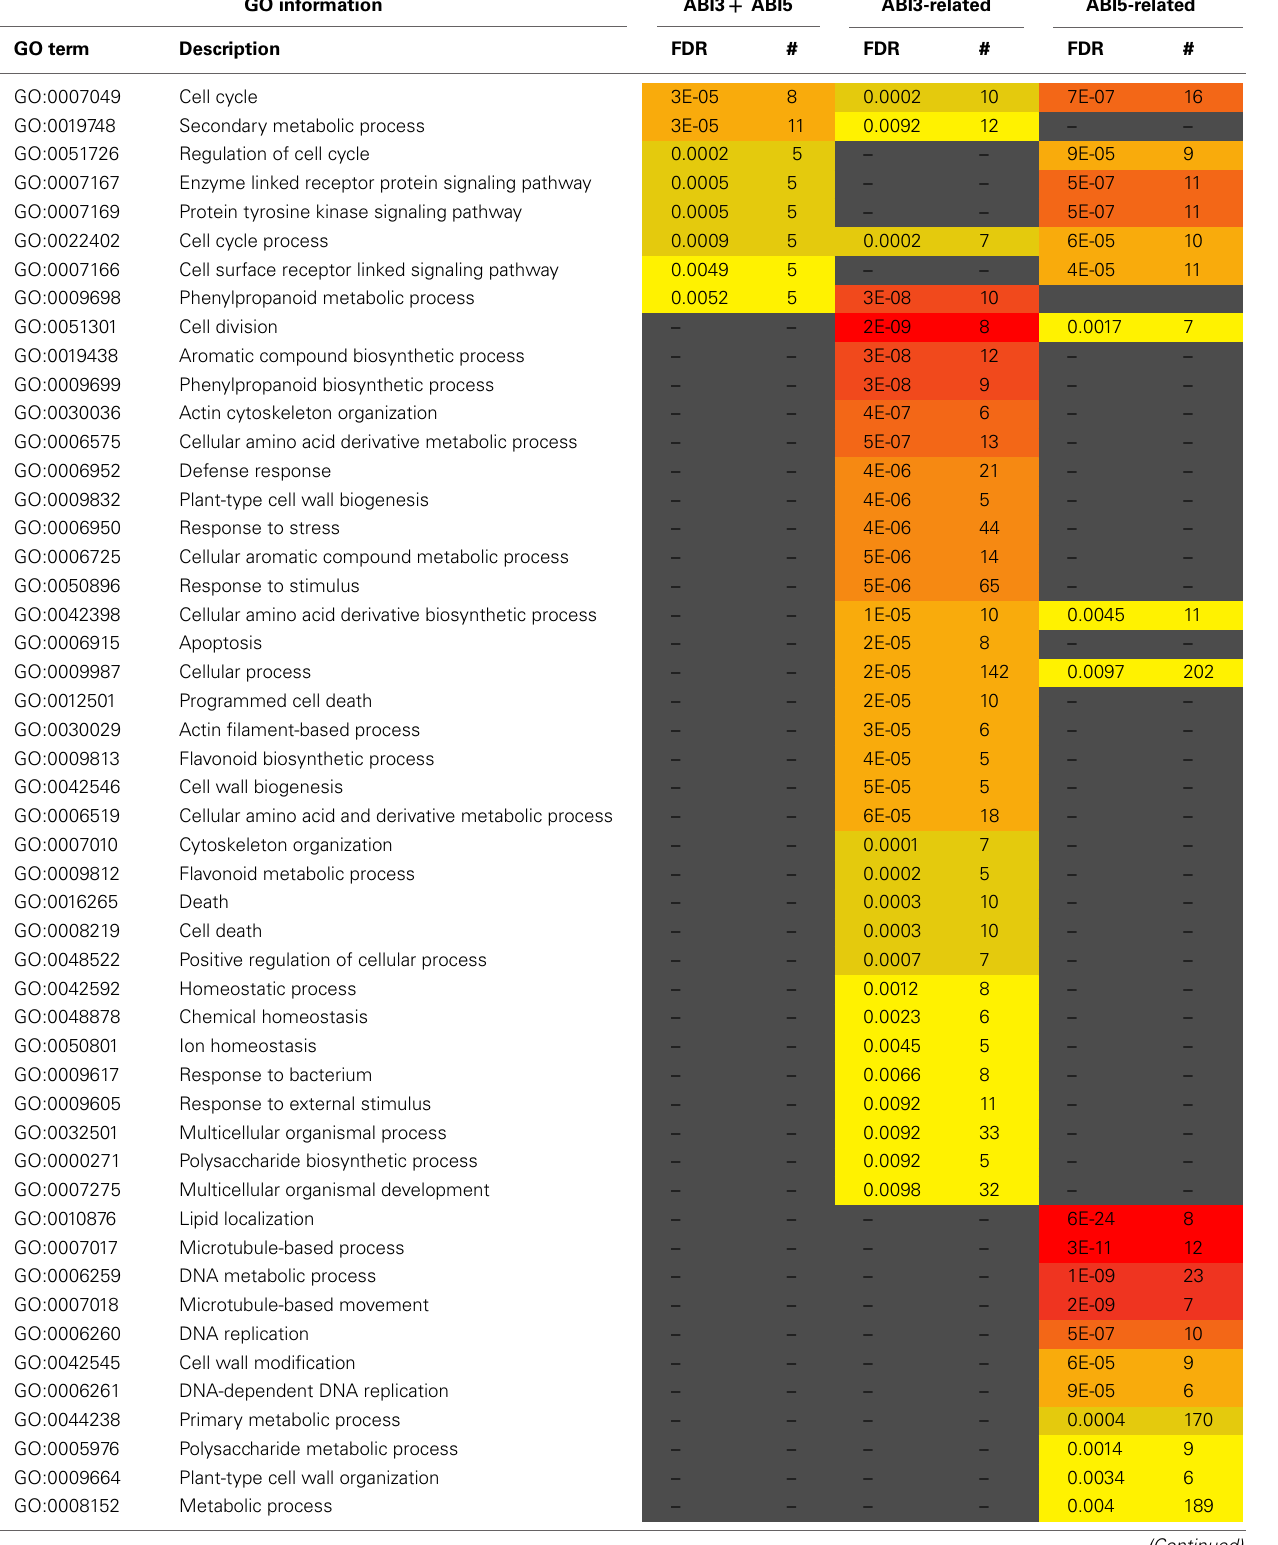
Table 4 | MtABI3 and MtABI5 are involved in complementary processes in relation to desiccation tolerance in Medicago truncatula